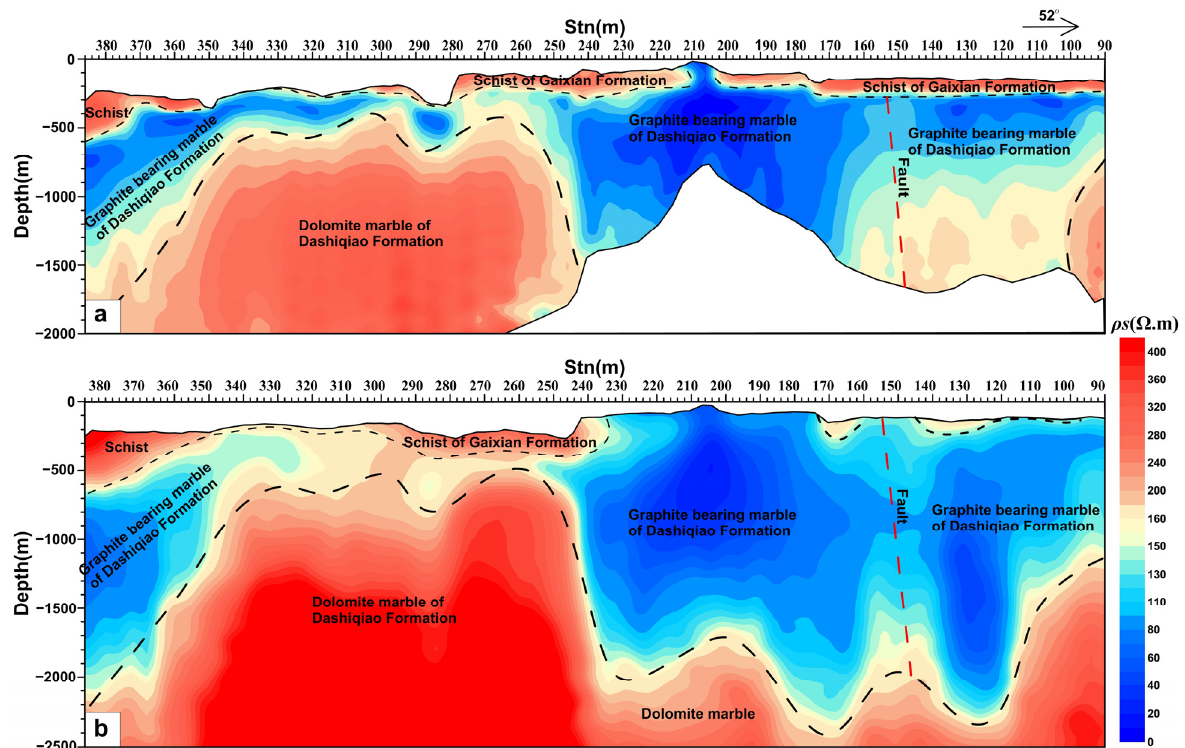
Figure 7. Inversion results comparison between SQUID magnetometer data and coil data. ( a ) Inver- sion results of induction coil data; ( b ) inversion results of SQUID data.